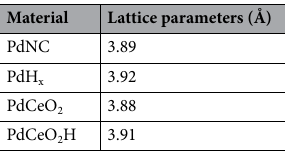
Table 1. Lattice parameters for PdNC and PdCeO 2 before and after